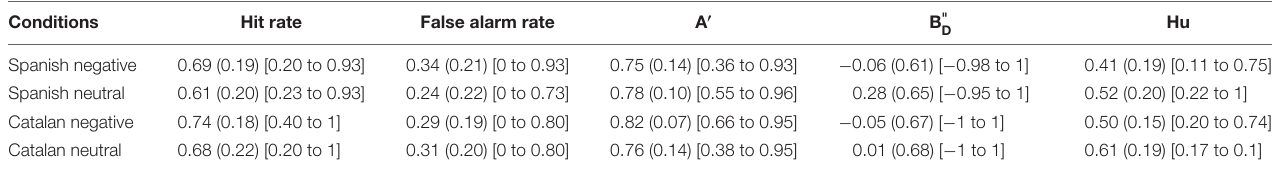
TABLE 3 | Mean, standard deviation (in parentheses), minimum and maximum values (in square brackets) of the dependent variables across experimental conditions in Experiment 2.